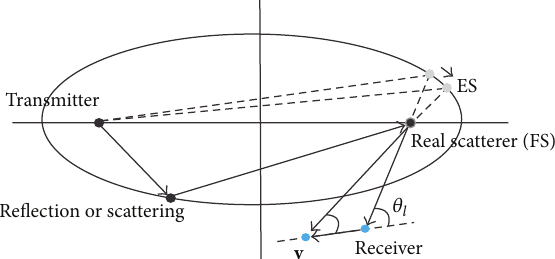
Figure 5: MPC of type M2: example of an ES moving along an elliptical trajectory while the FS is fixed during the receiver movement. The FS is located at the position of the last real scatterer of the path.